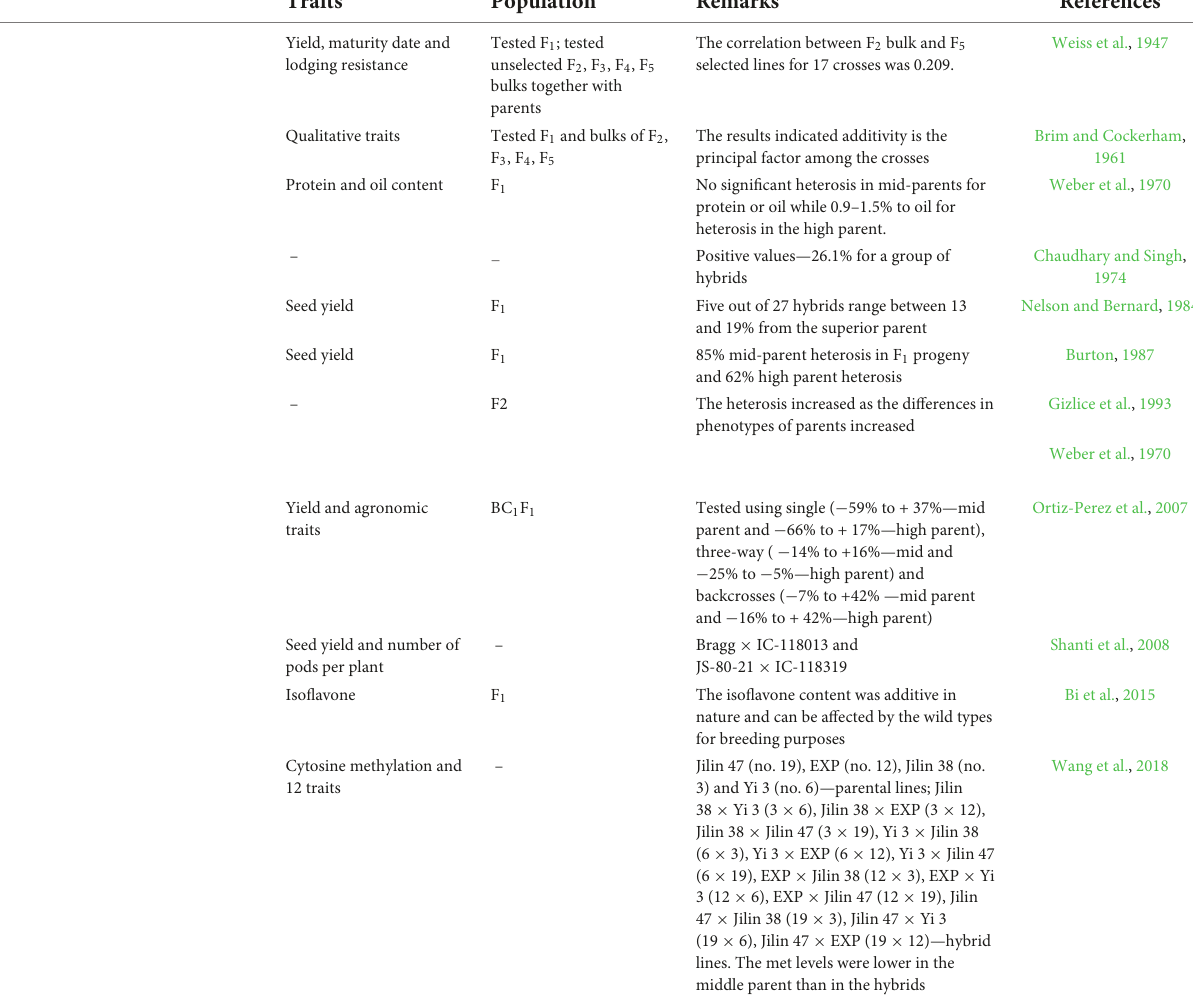
TABLE 1 Development of heterosis in